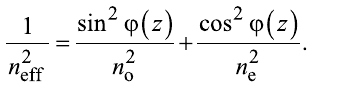
Figure 6b) segregation of CNTs in the layer have been exam-